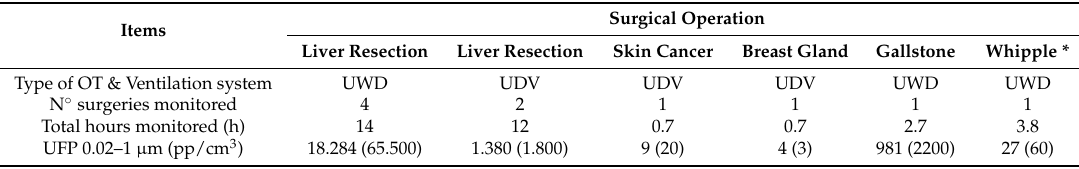
Table 3. Type of OT ventilation systems and surgeries during the measuring campaign. Time average number of UFP concentrations (pp/cm 3 ) detected close to the surgical table at the surgeon site (P1-Sur) during different surgical operations (standard deviation within brackets).